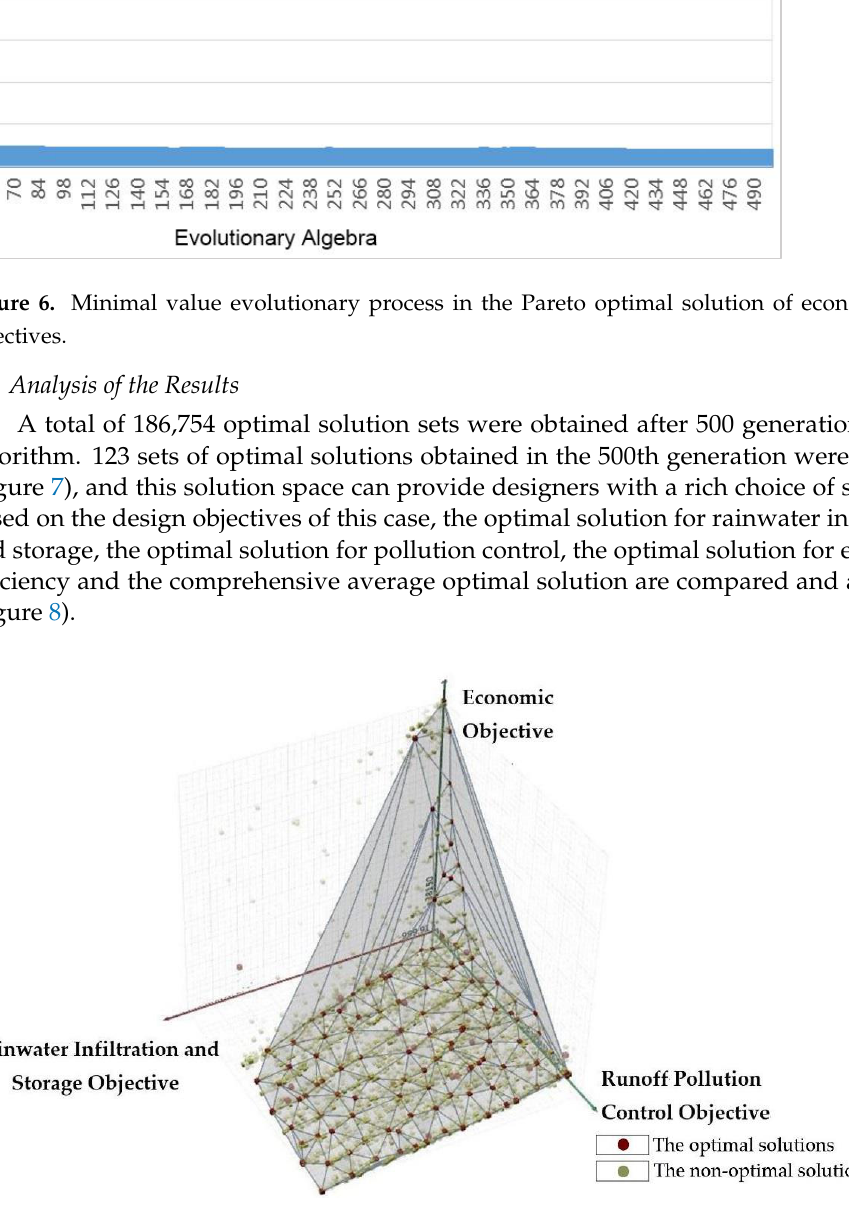
Figure 7. Spatial distribution of multi-objective optimal solutions for rainwater infiltration, runoff pollution control, economy and cost of sponge facilities.